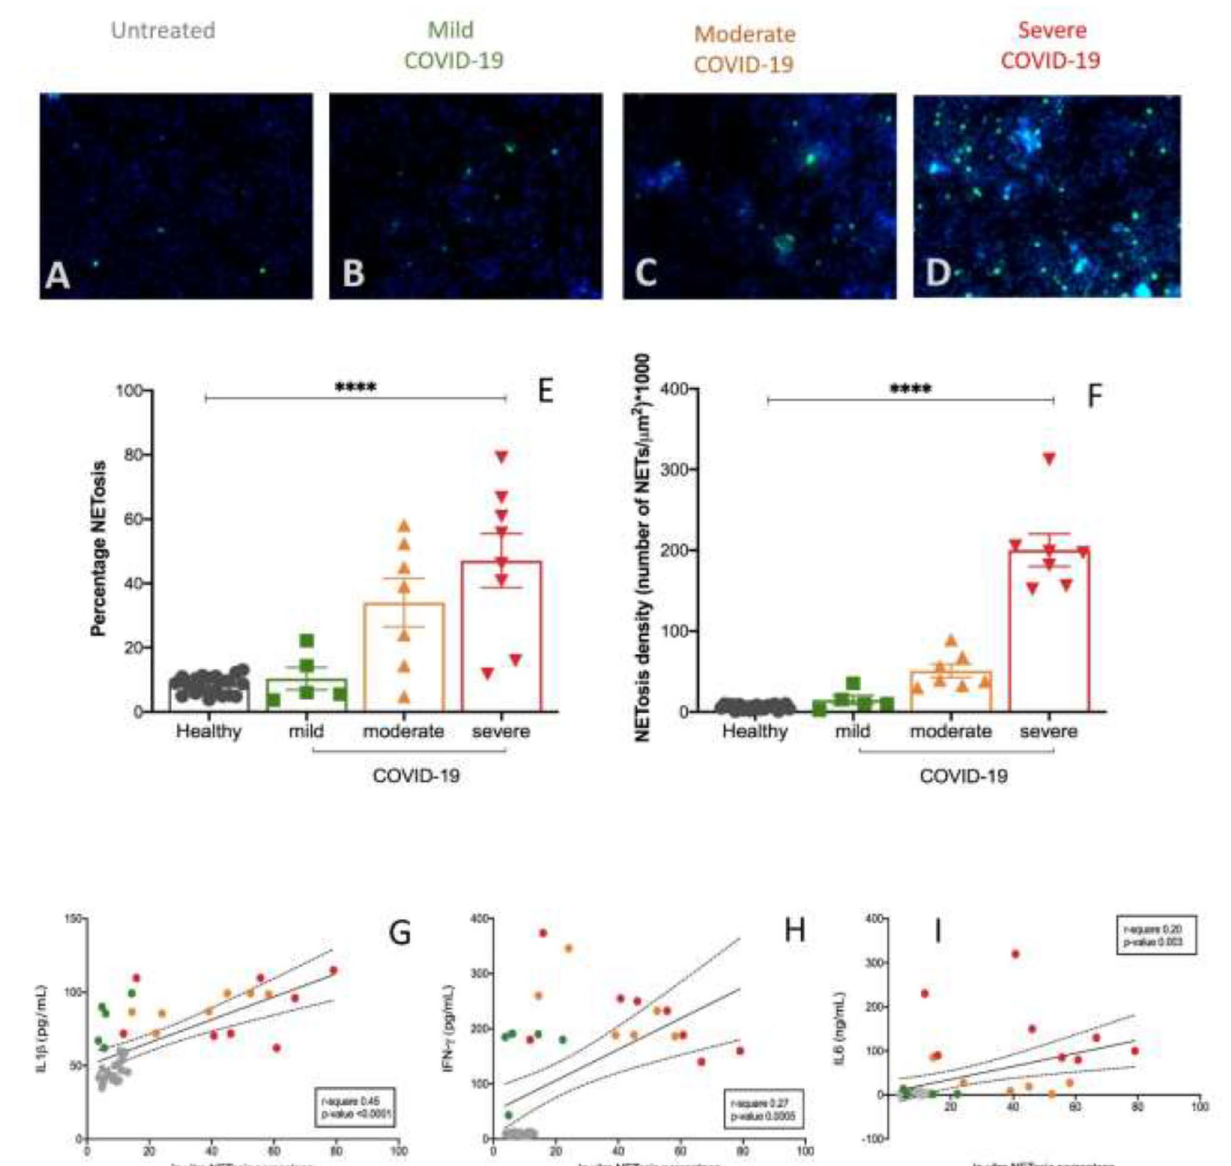
Figure 6. In vitro assessment of NET-osis is associated to clinical severity of COVID-19. High density neutrophils were isolated from three healthy subjects using a density gradient as described in Methods and previously 44–46 ; purity was assessed as shown in Supplementary Fig. 1. After isolation, HDNs were maintained in culture with 10% FBS complete RPMI media for 2 h and exposed to sera obtained from healthy or COVID- 19 subjects for 3 h. DAPI and cit-H3 staining of DNA revealed the presence of neutrophil extracellular traps (NETs), as shown in panels ( A–D) . (E) percentage of NET-s and (F) NET density were quantified and plotted. Bars represent mean and standard deviation. Stars denote ANOVA among the three COVID groups (mild, moderate, severe), *p < 0.005, ** p < 0.001. Correlation among the quantity of percentage of in-vitro NET-osis and amount of IL-1β (G) , IFN-γ (H) and IL-6 (I) is shown. Color code: grey, healthy subjects; green, mild COVID-19; orange, moderate COVID-10, red, severe COVID-19. COVID-19 severity was defined according to qCSI, based on respiratory rate, pulse oximetry and oxygen flow T-cells 21,22 and B-cell responses 23,24 , including the activation of memory and naïve B-cell subpopulations 25 , even if in lack of a long-lasting immune response 24 . Our data confirm previous observations of memory B cell loss in COVID-19 patients with acute severe disease 26 , although in our cohort was not possible to make conclusions regarding antigen-specific memory B cells. Recruitment of CD14 + CD16 + inflammatory monocytes (IM) can play both protective and detrimental roles in viral infections, due their ability to produce Th1-polarizing cytokines, present antigen to CD8+ T cells, pro- mote survival of certain memory CD8 + T cell subsets, or promote viral clearance through type I IFN and other